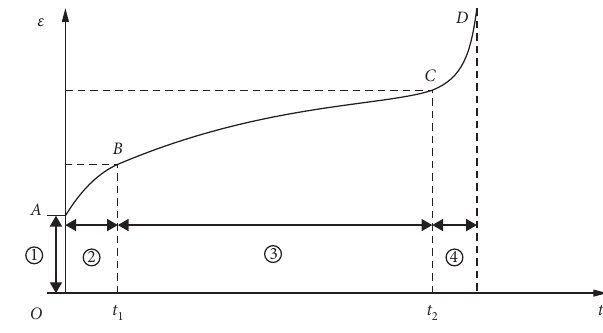
Figure 2: The four stages of rock